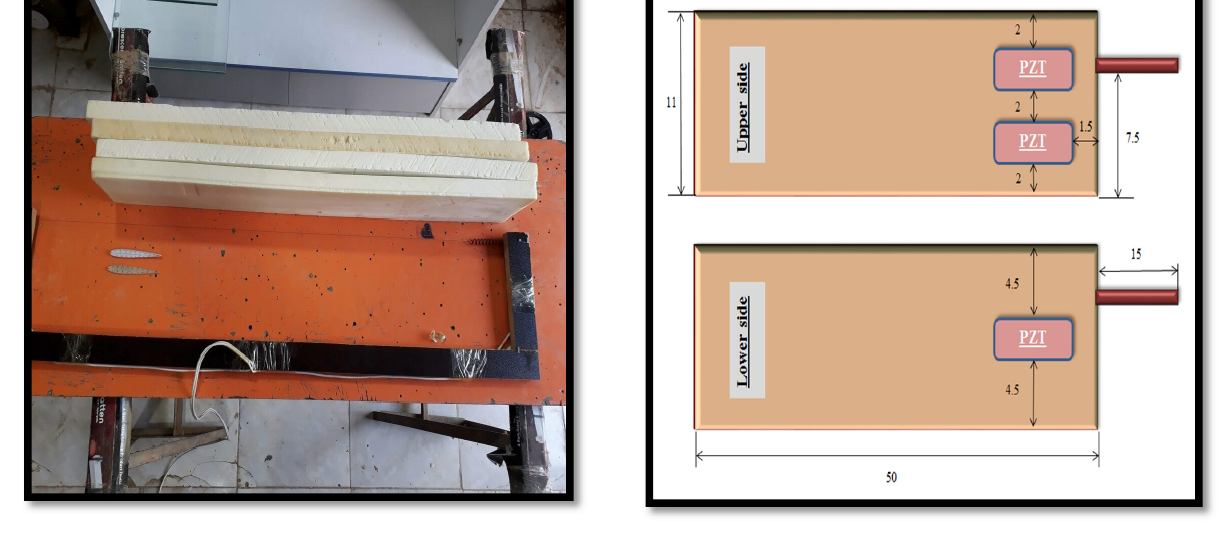
Fig. 1. The hot wire device. Fig. 2. The dimension of the device.